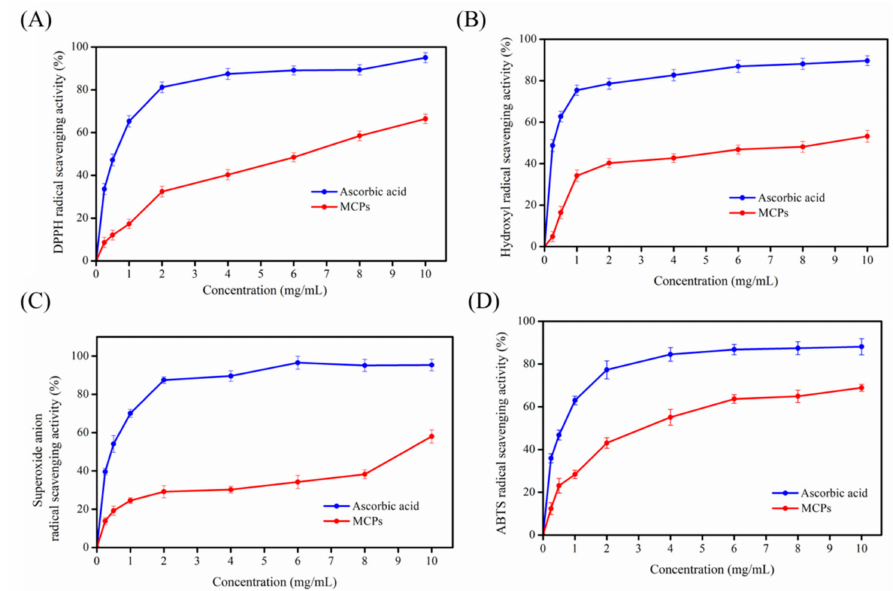
Figure 3. 2, 2-diphenyl-1-picrylhydrazyl (DPPH) ( A ), Hydroxyl ( B ), superoxide anion ( C ) and ABTS ( D ) radical scavenging activities of MCP s from Nibea japonica skins. All assays were performed in